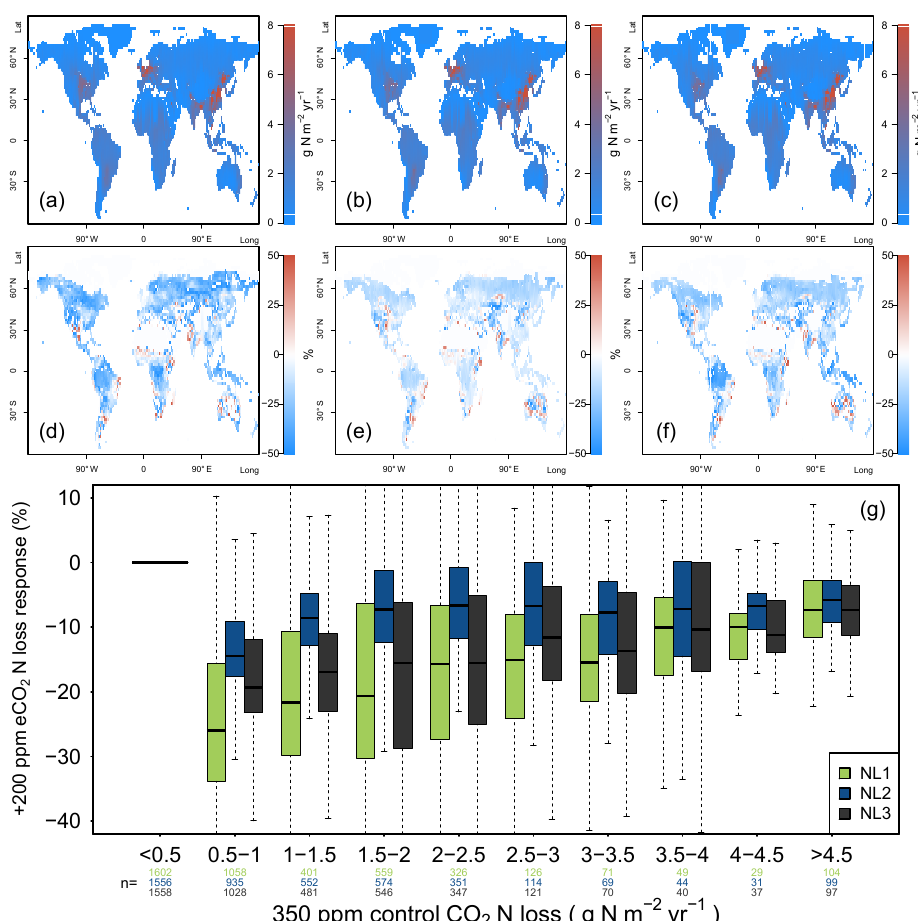
Figure 4. (a, b, c) Global nitrogen (N) loss rates (gNm − 2 yr − 1 ) for the control state (350ppm atmospheric CO 2 concentration), using the N loss algorithms NL1 (a) , NL2 (b) , and NL3 (c) . (d, e, f) Global N loss responses (%) to elevated atmospheric CO 2 concentrations (eCO 2 , + 200ppm gradual increase). (g) Global response ratios (%) plotted against the corresponding control N loss rates, binned in inter- vals of 0.5gNm − 2 yr − 1 . Boxes show median and quartiles; whiskers show the largest/smallest outliers that lie below/above 1.5 times the interquartile range. Further outliers were omitted. Coloured numbers indicate the number of 2 ◦ × 2 ◦ grid cells that fell into the respective N loss range. The 350–550ppm difference in atmospheric CO 2 concentrations approximately corresponded to the 1988–2052 time span in our global